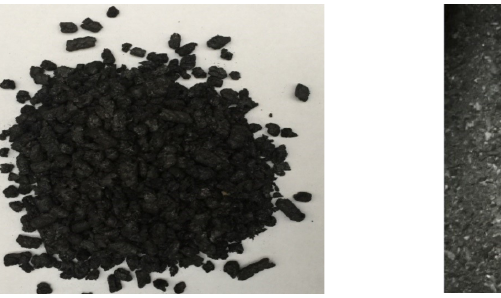
Table 4. Grain size analysis and bulk densities of biochars and coke breeze.